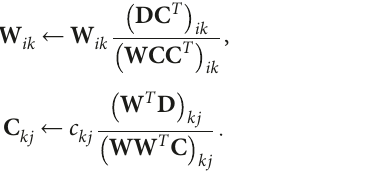
Figure 2: Simulated muscle synergy vectors: (a) the independent synergy vectors W one synergy; (b) the dependent synergy vectors W D , in which the contribution of muscle M1 is comparable between the two